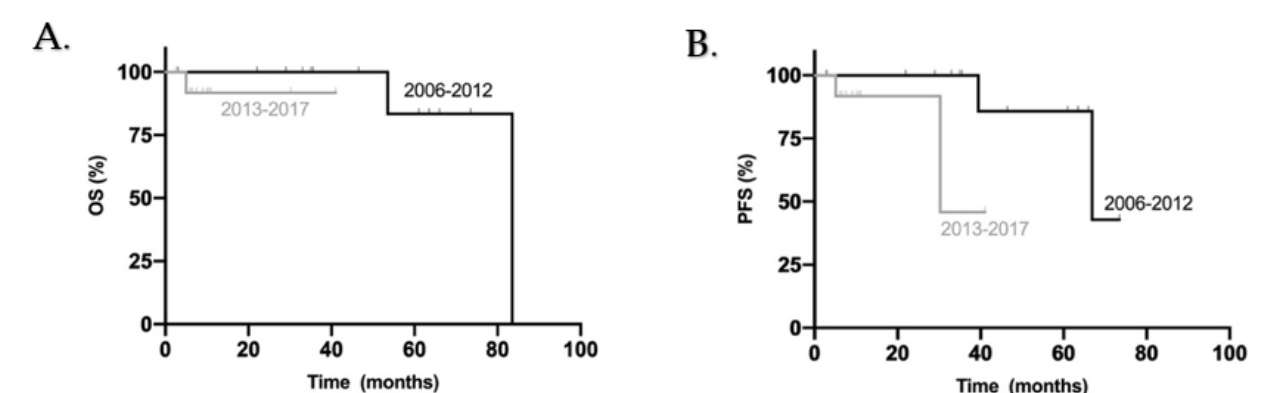
Figure 4. Kaplan–Meier overall survival ( A ) and progress-free survival ( B ) curves for all adult patients included in this study according to year of diagnosis.